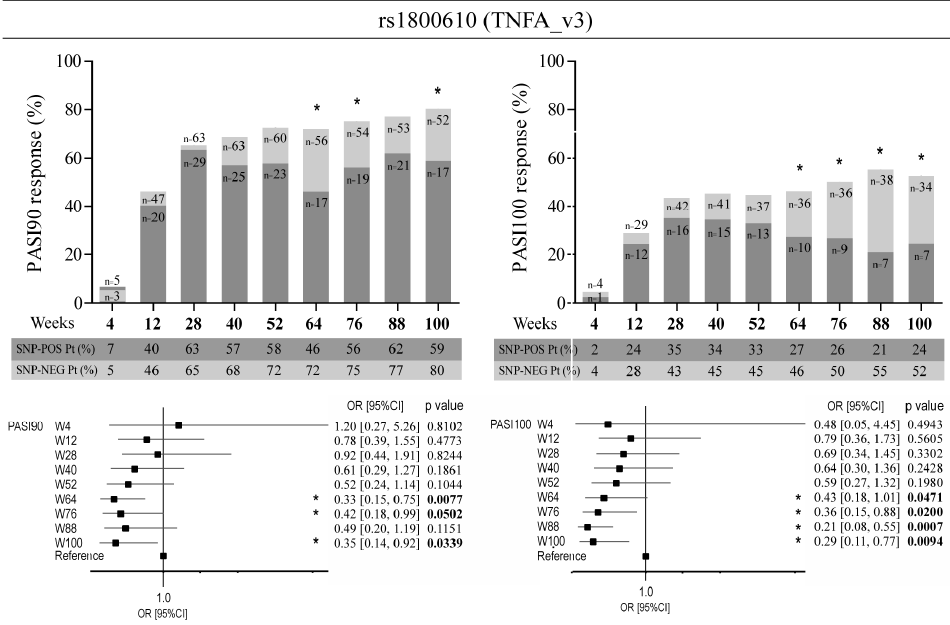
Figure 5. Association analysis between rs1800610 in TNFA and response to ustekinumab. Rs1800610 (TNFA_v3)-positive patients (light grey bars) reached a significant better response to ustekinumab than SNP-negative (dark grey bars) subjects, in terms of achievement of PASI90 and PASI100, as evaluated by logistic regression analysis. Numbers in the bars indicate the exact number of subjects carrying or not the alleles. The tables under the graphs show the percentage of patients (Pt) at the time-points of observation, carrying (SNP-POS) or not carrying (SNP-NEG) the relevant alleles. * p values < 0.05 were considered significant. The univariate logistic regression analyses are also summarized in forest plots. The condition of good response to ustekinumab is more likely to occur in the group of patients not carrying the allele, as indicated by the OR < 1. Squares on the x -axis shows OR estimates for each observation point and the error bars represent 95% CI. * p values < 0.05 were considered significant and indicated in bold font.